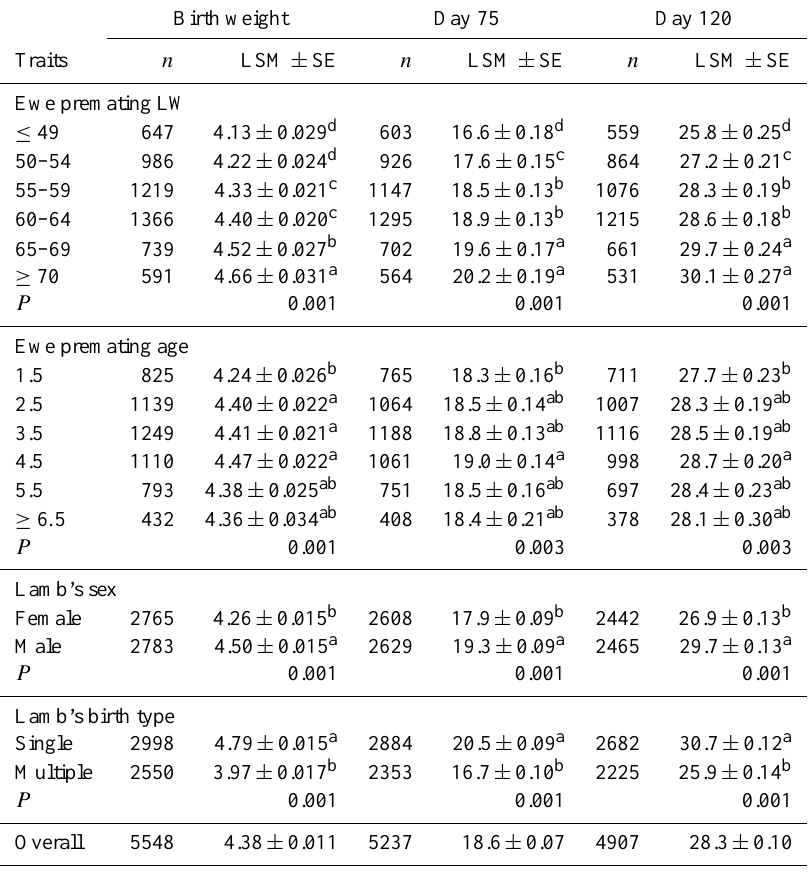
Table 10. The effects of ewe premating live weight and age, lamb’s sex, and birth type on the birth weight and growth performance of the lambs. ∗